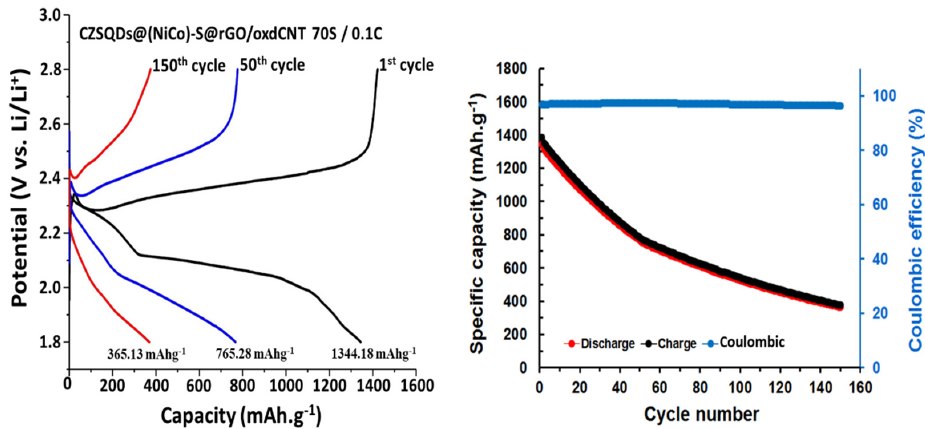
Figure 14. Charge/discharge curves, cycle performance and Coulombic efficiency of CZSQDs@(NiCo)–S@rGO/oxdCNT/S at the current density of 0.1 C at 1st, 50th and 150th cycles.